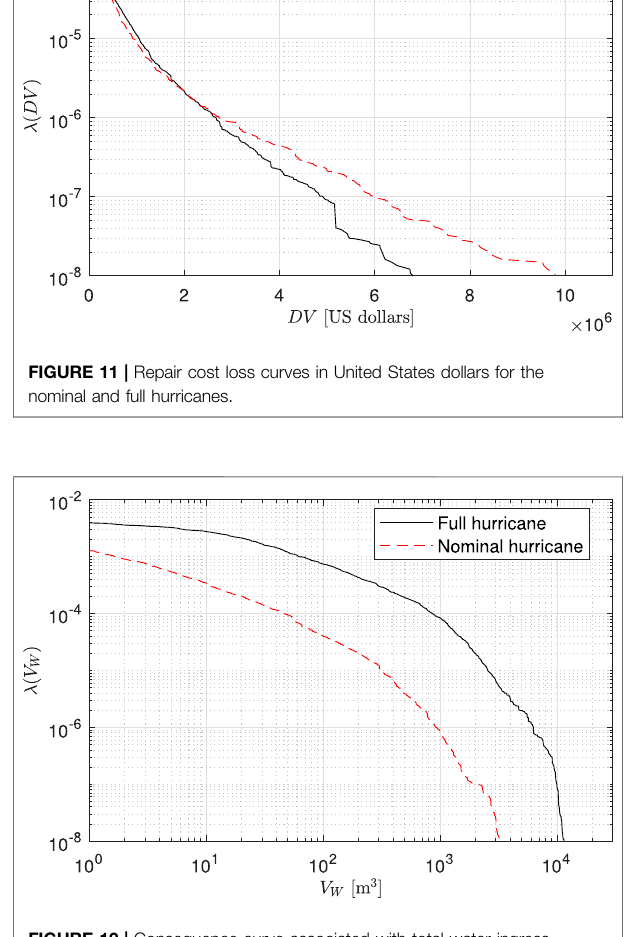
FIGURE 12 | Consequence curve associated with total water ingress due to envelope damage.